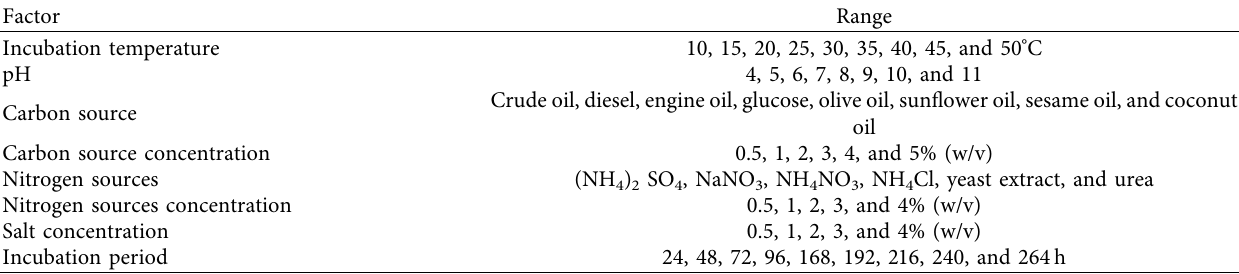
Table 1: Factors considered for optimization of biosurfactant production from identifed